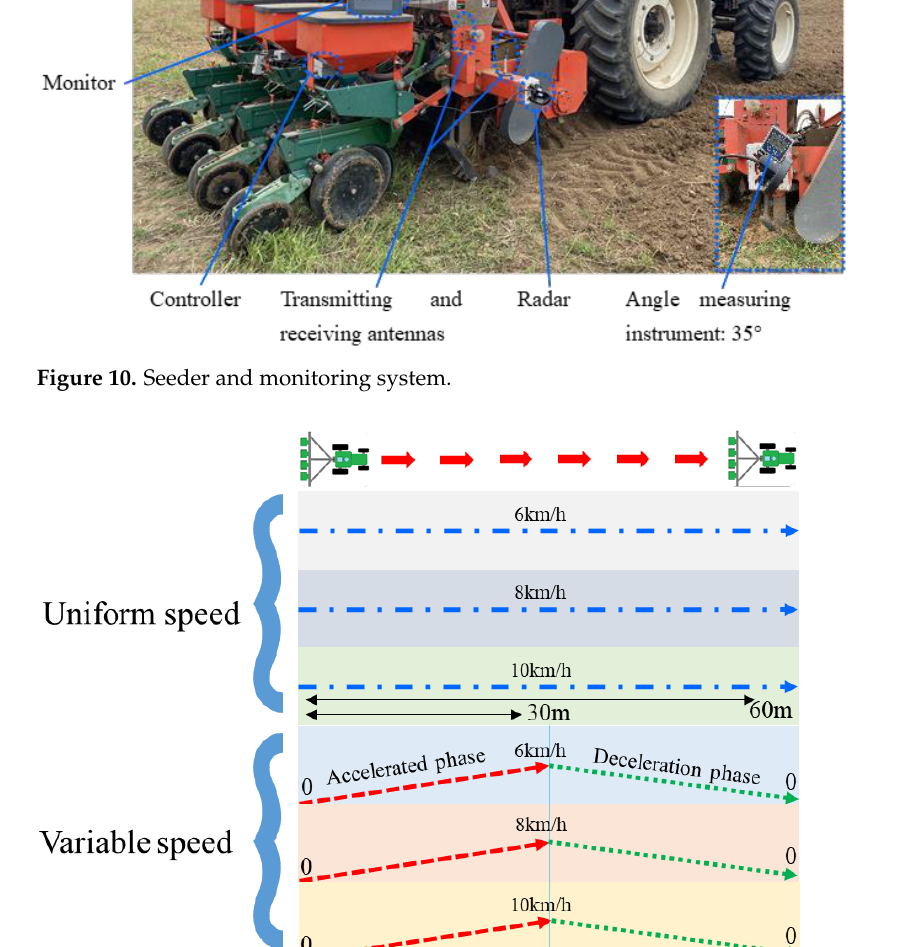
Figure 11. Target plan for field testing.